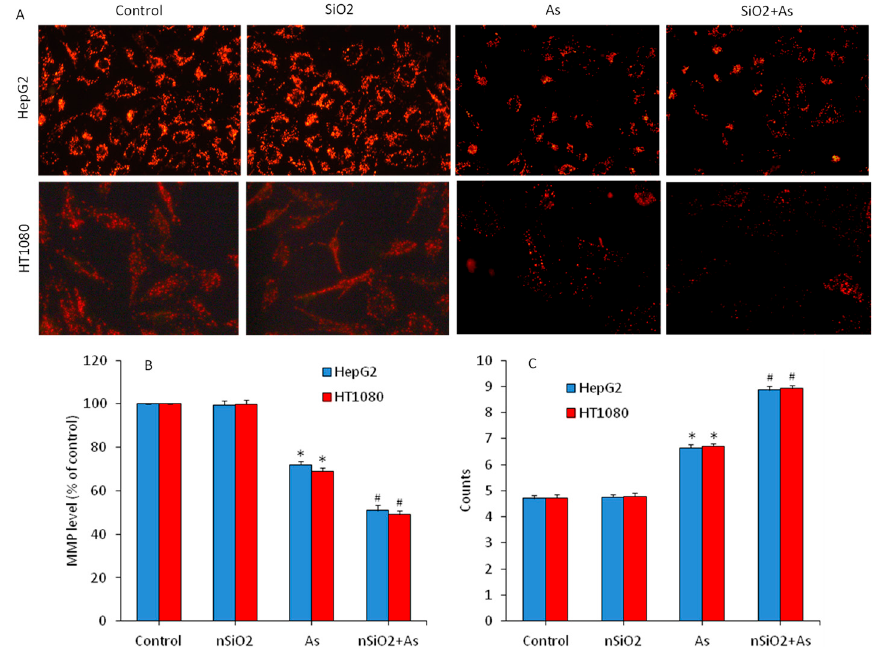
Figure 6. Mitochondrial membrane potential (MMP) level and cell cycle phases of HepG2 and HT1080 cells exposed for 24 h to nSiO 2 (10 µ g / mL), As (1 µ g / mL) or SiO 2 + As (10 µ g / mL + 1 µ g / mL). ( A ) Fluorescent microscopic images of MMP level (rhodamine-123 (Rh-123) probe). ( B ) Quantitative level of MMP. ( C ) SubG1 phases of cell cycle. Data are presented as the mean ± SD of three independent experiments (n = 3). * indicates significant e ff ect in comparison to the control group ( p < 0.05). # indicates significant e ff ect in comparison to the nSiO 2 group alone or the As group alone ( p < 0.05).